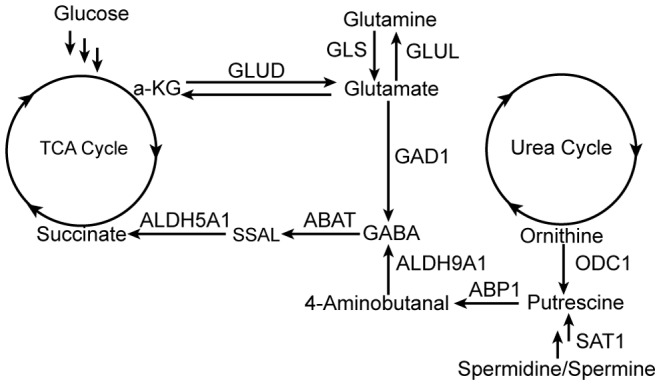
GABA synthetic and metabolic pathways in NE cells.GLUD: glutamate dehydrogenase; GLS: glutaminase; GLUL: glutamate-ammonia ligase; GAD1: glutamate decarboxylase; ODC1: ornithine decarboxylase; ABP1: diamine oxidase; ABAT: GABA transaminase; SSAL: succinic semialdehyde; ALDH5A1: succinic acid semialdehyde dehydrogenase; ALDH9A1: aldehyde dehydrogenase; SAT1: spermidine/spermine N-acetyltransferase.